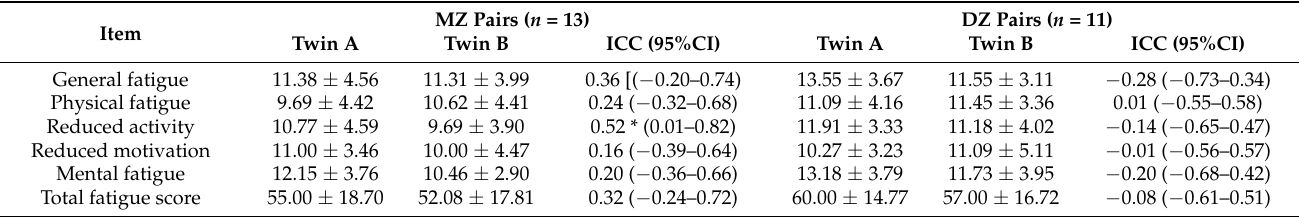
Table 5. Fatigue symptoms in MZ and DZ twin pairs concordantly experiencing increased fatigue since the COVID-19 pandemic (reported as mean ± standard deviation) and intra-class correlations (reported as ICC coefficients and 95% CI).